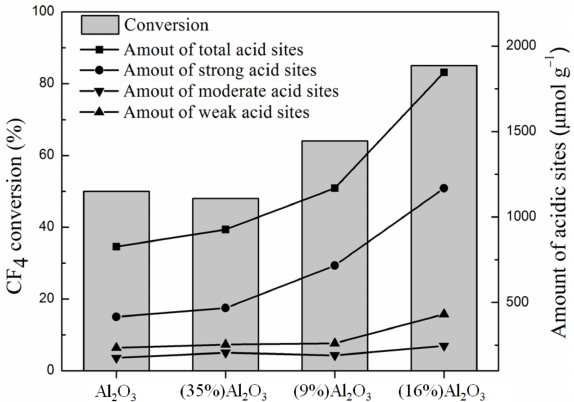
Figure 8. Correction between CF 4 conversion and amounts of different kind of acidic sites.